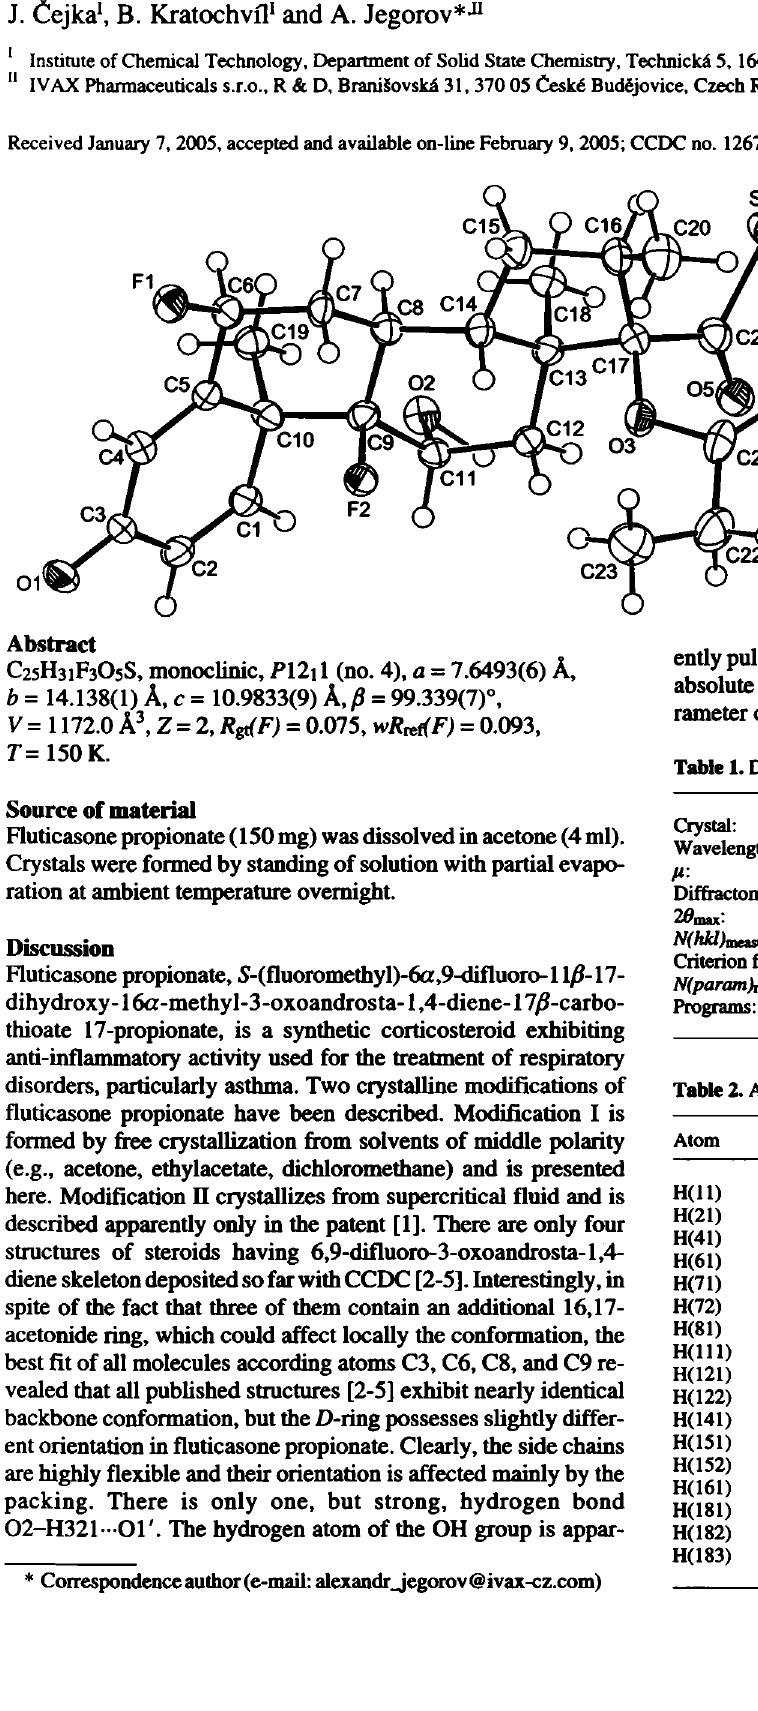
Table 1. Data collection and handling.